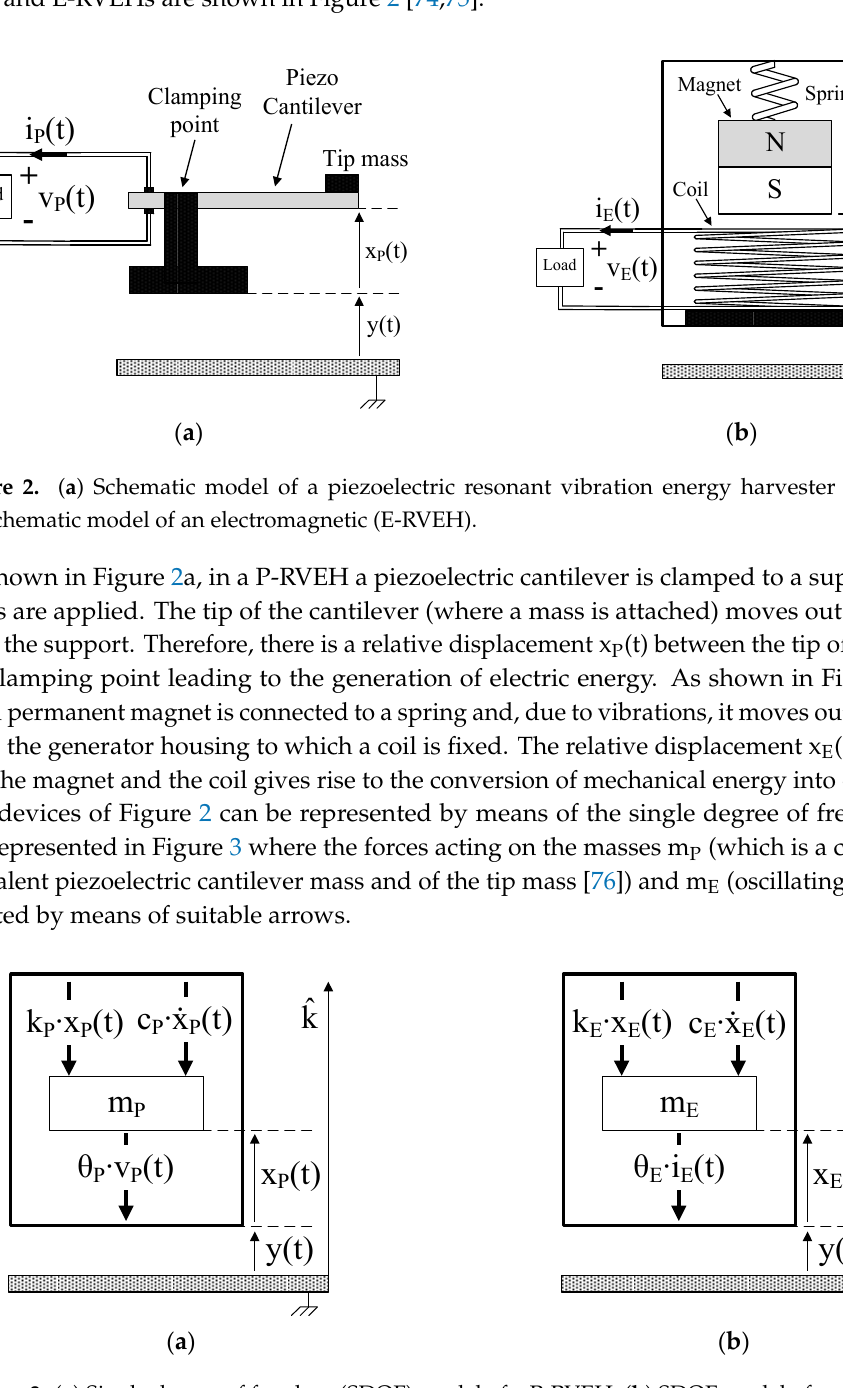
Figure 3. ( a ) Single degree of freedom (SDOF) model of a P-RVEH. ( b ) SDOF model of an E-RVEH.